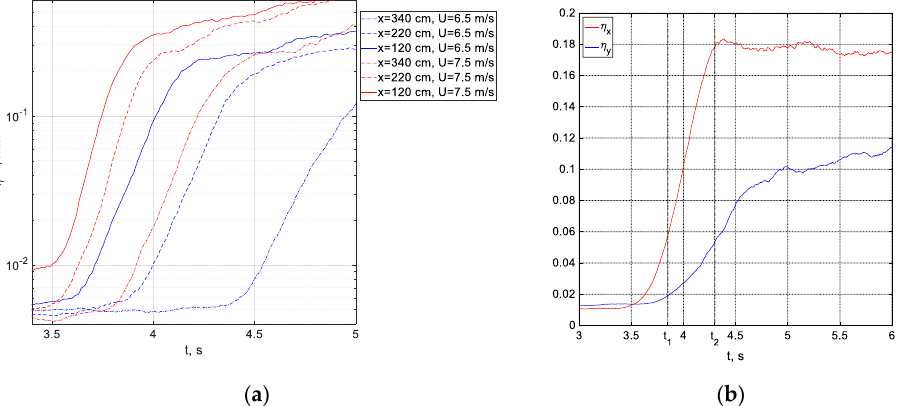
Figure 27. Appearance of initial ripples: ( a ) Exponential growth of ripples’ energy; ( b ) the growth of ripples’ slope components. Vertical broken lines denote transition instants t 1 and t 2 , as defined in Figure 26.